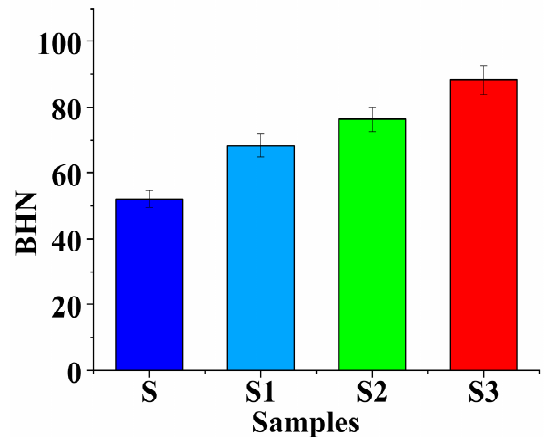
Figure 4. Hardness value of the samples.